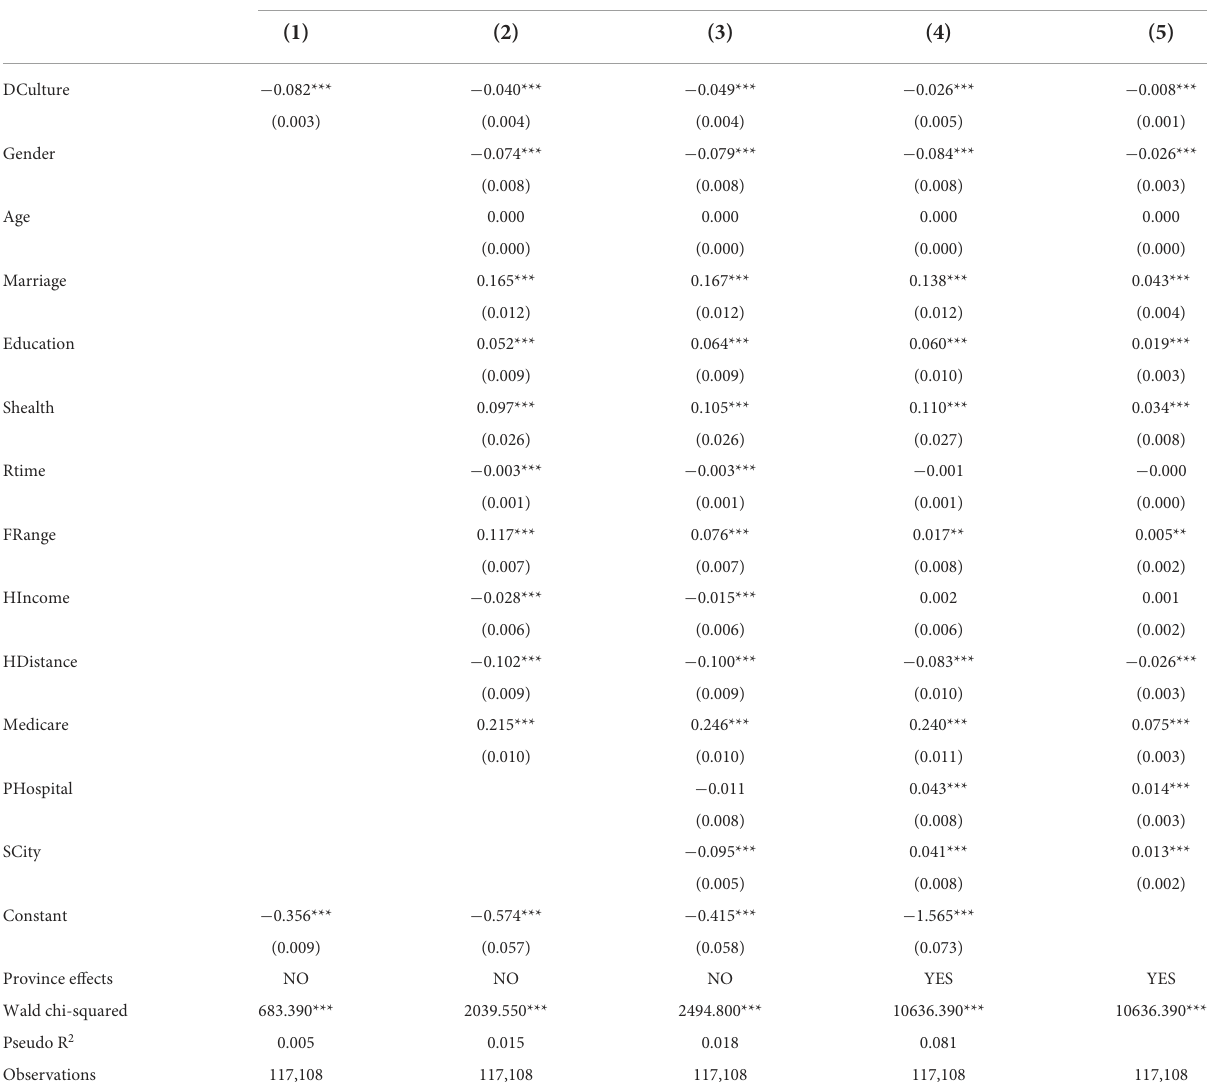
TABLE 2 Probit estimates of the effects of DCulture on PHSU of rural